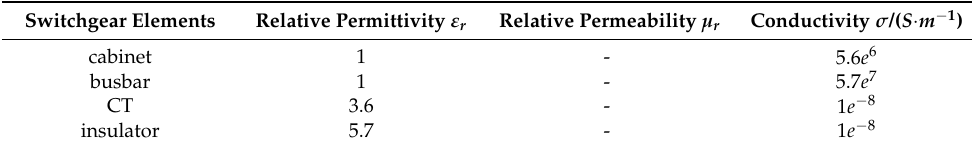
Table 1. Material parameters of components of switchgear.